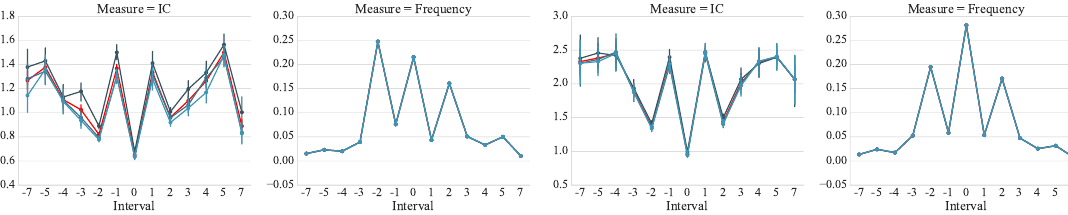
Figure 6. Pitch interval versus IC stability for the T UNE F AM -26 (left) and C SV -60 (right) datasets using three different alignment configurations. Interval frequencies per dataset are also presented. Results for only the 13 most frequent intervals are